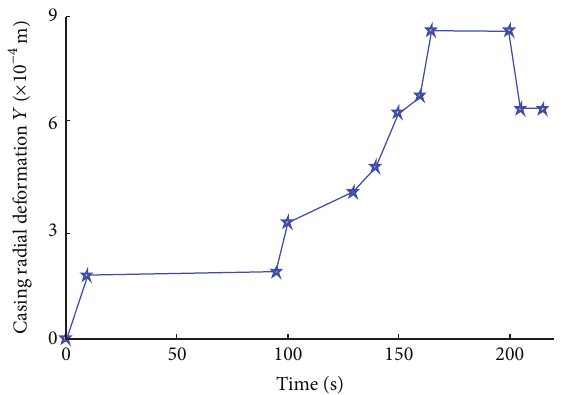
Figure 4: Variation of casing radial deformation 𝑌 .